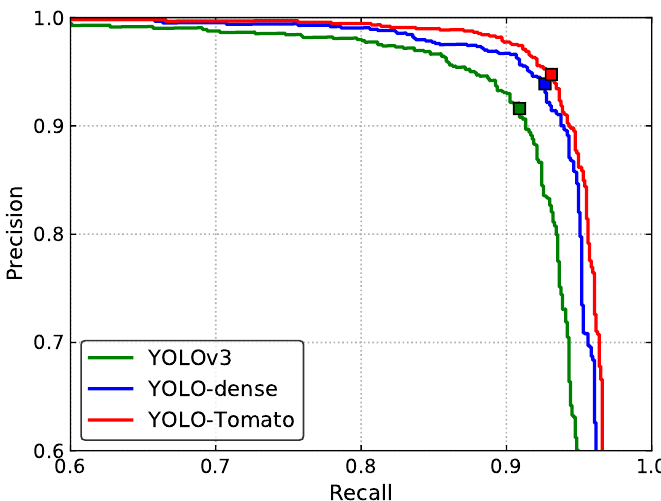
Figure 11. P–R curves of different methods for ablation study. The markers indicate the points where recall and precision are obtained when the prediction confidence threshold equals